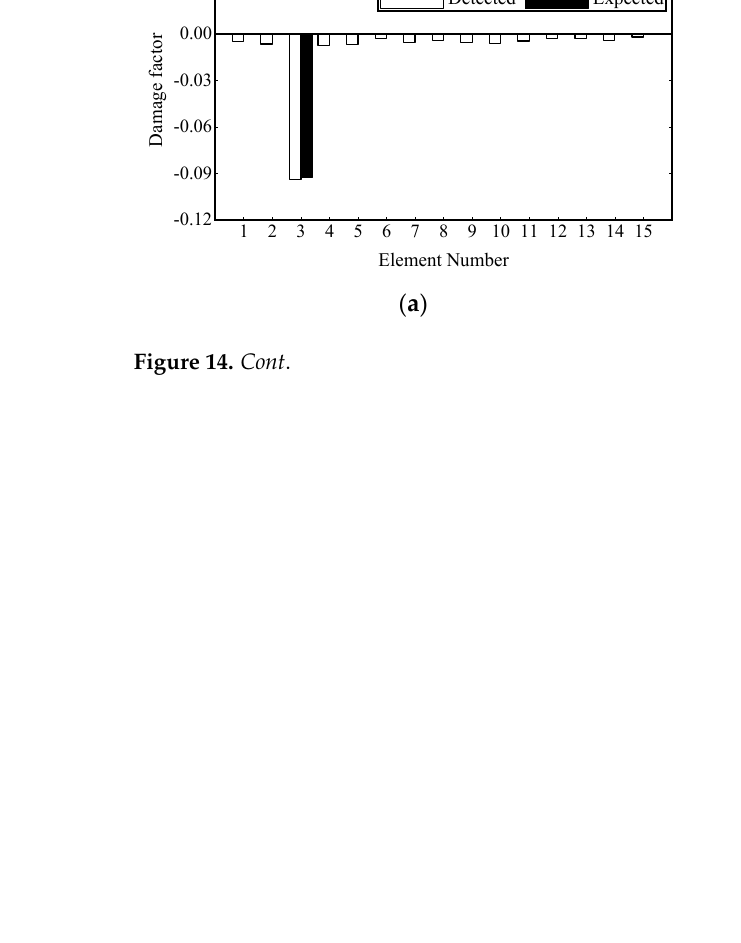
Figure 13. Convergence curve of damage identification: ( a ) damage factor; ( b ) relative error. Table 4. The number of iterations and time consumption for convergence under different damage scenarios.